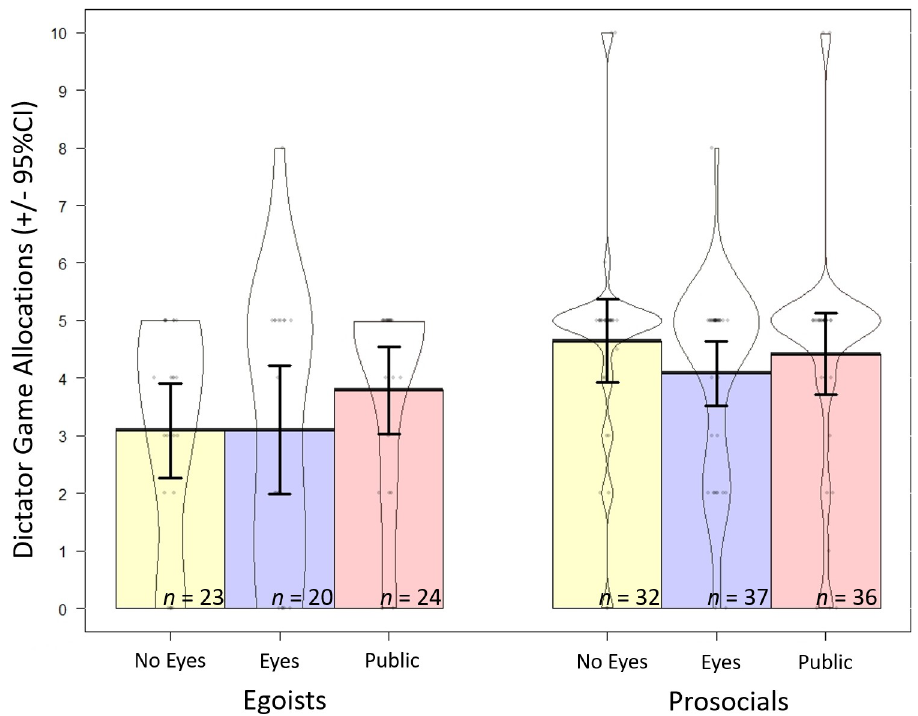
Fig 4. Dictator game allocations by condition and SVO (+/- 95% CIs). Colored areas represent traditional bar graphs, where egoists are in blue, and prosocials in green. Contours are violin plots which demonstrate the distribution of responses for that condition. Dots are individual responses, with jitter so they don’t all